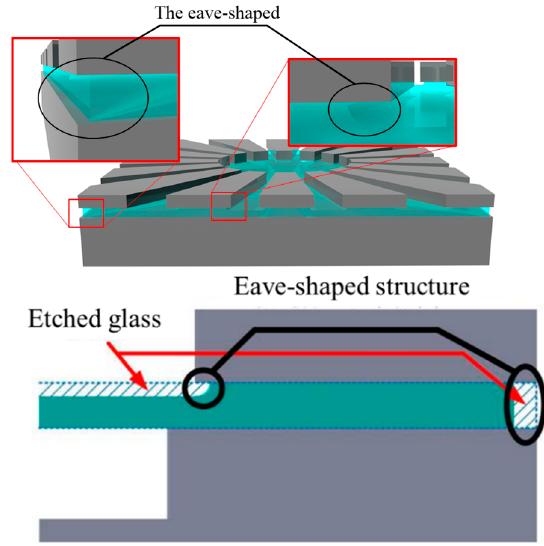
Figure 5. Illustration of the eave-shaped